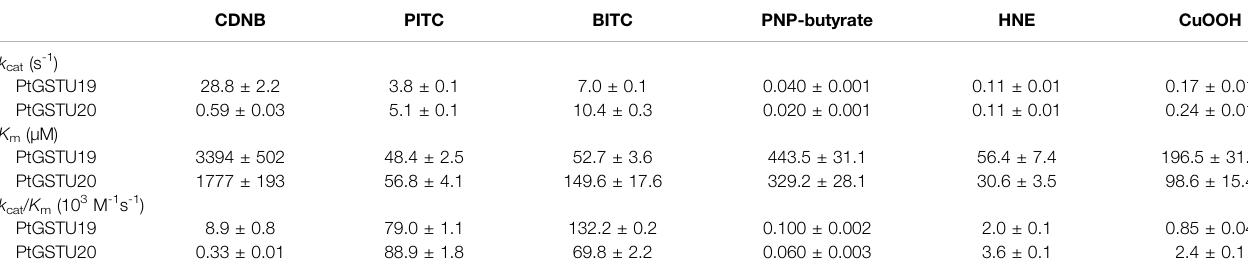
TABLE 2 | Kinetic parameters of PtGSTU19 and 20 toward model